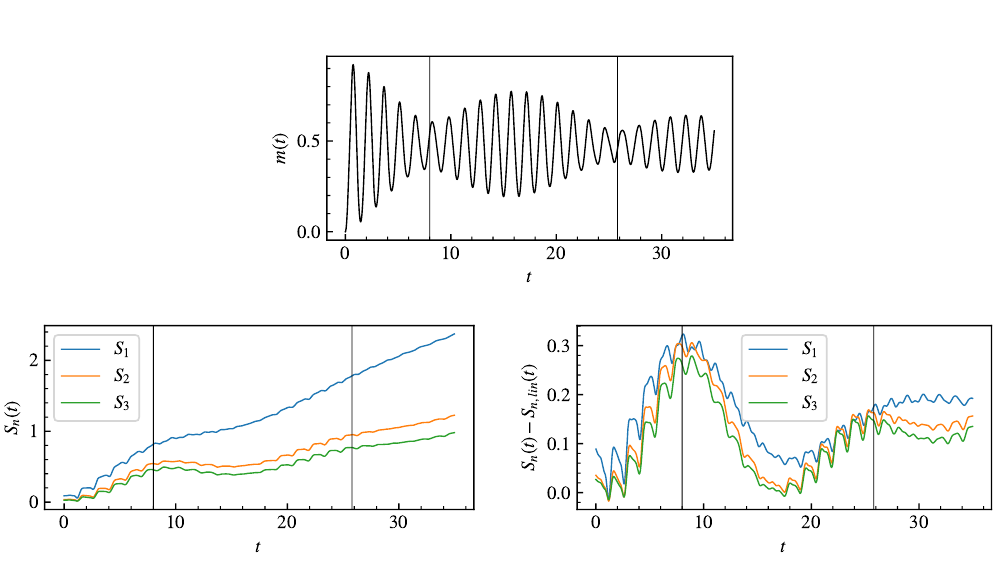
Figure B.8: Time evolution of various quantities after a large quench ( g ) = ( 2.0,0.0 ) → ( g , h ) = ( 2.0,0.9 ) in the quantum Ising spin chain. The , h 0 0 top left diagram shows the evolution of magnetisation, the top right one the von Neumann entropy ( S ) and two of the Rényi entropies ( S 1 one shows the entropy evolution with the linear trend subtracted. The vertical lines correspond to a single period of the slow oscillation corresponding to the frequency − m 2 m . The first line is drawn at the first minimum of the envelope of the magneti- 1 2 sation oscillations while second is drawn at a distance given by the period T ≈ 17.8. Note that their position also matches the behaviour of the entropy curves quite well. Time is measured in units of 1 / J , and the initial entropy was